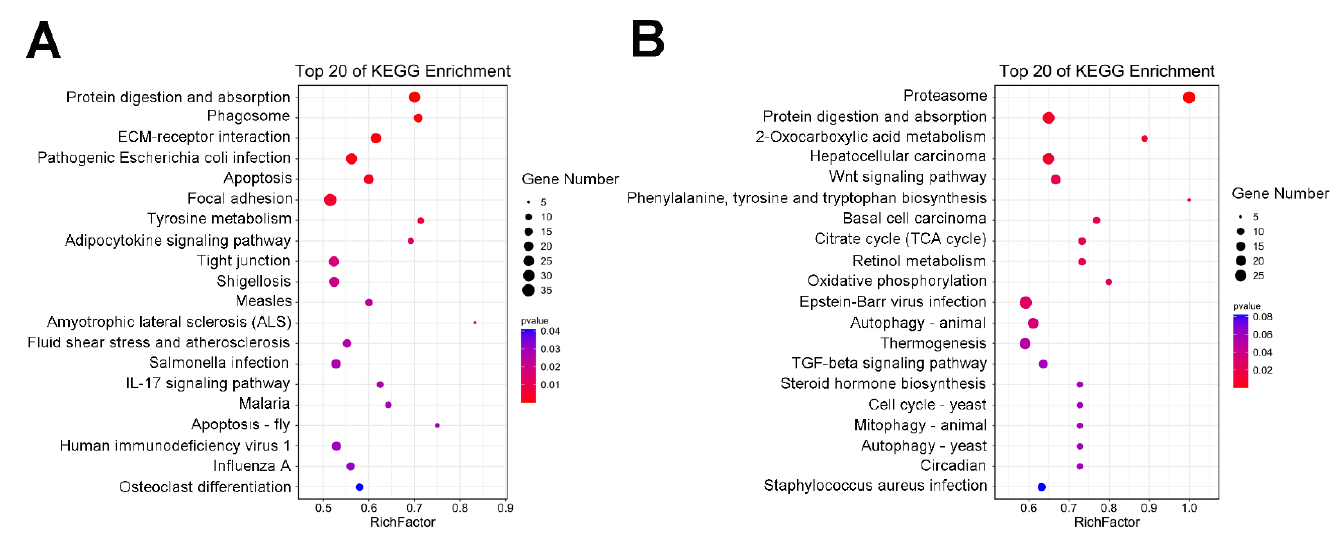
Figure 6. KEGG analysis of DEGs. ( A ) Circular graph of initial vs. black. ( B ) Circular graph of initial vs. blue.